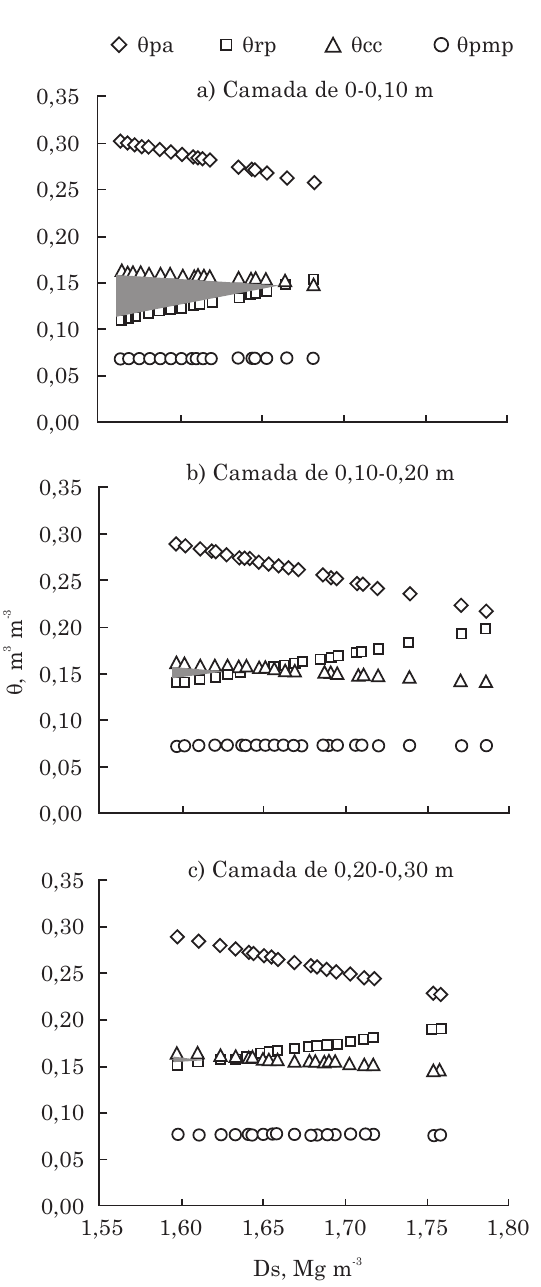
Figura 2. θθθθθ em função da Ds para as camadas de 0- 0,10 (a), 0,10-0,20 (b) e 0,20-0,30 m (c) do Latossolo Vermelho distrófico típico em sistema de integração lavoura-pecuária. As áreas hachuradas em cinza correspondem ao IHO, para os limites críticos de -80 hPa, -15.000 hPa, 2,5 MPa e 0,10 m 3 m -3 , respectivamente para θθθθθ cc , θθθθ θ θθθθ θ θθθθ θ pmp , rp e pa .